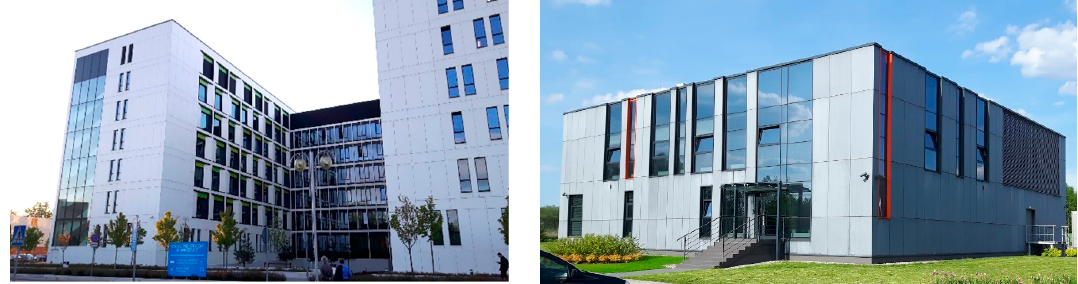
Figure 1. Exemplary uses of fibre-cement boards as ventilated façade cladding.